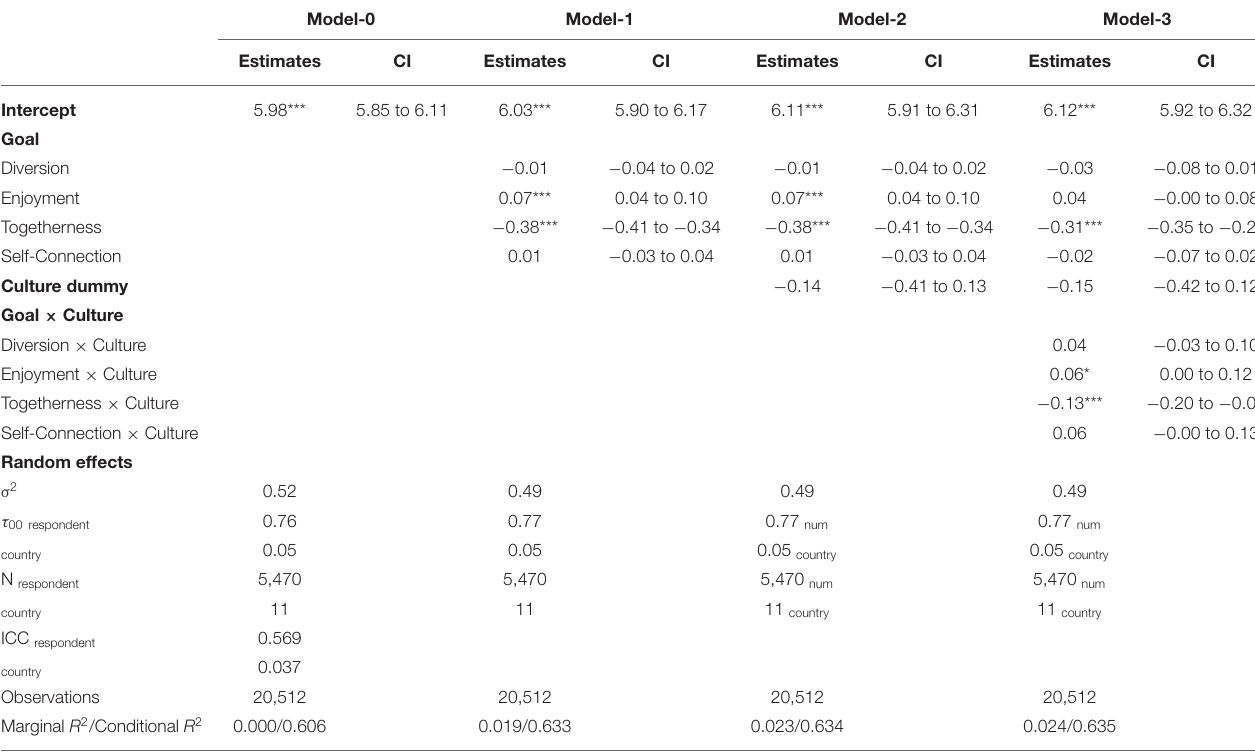
TABLE 2 | Overview of main statistical outcomes of multilevel regression models testing the efficiency of music in obtaining wellbeing goals by Goal and